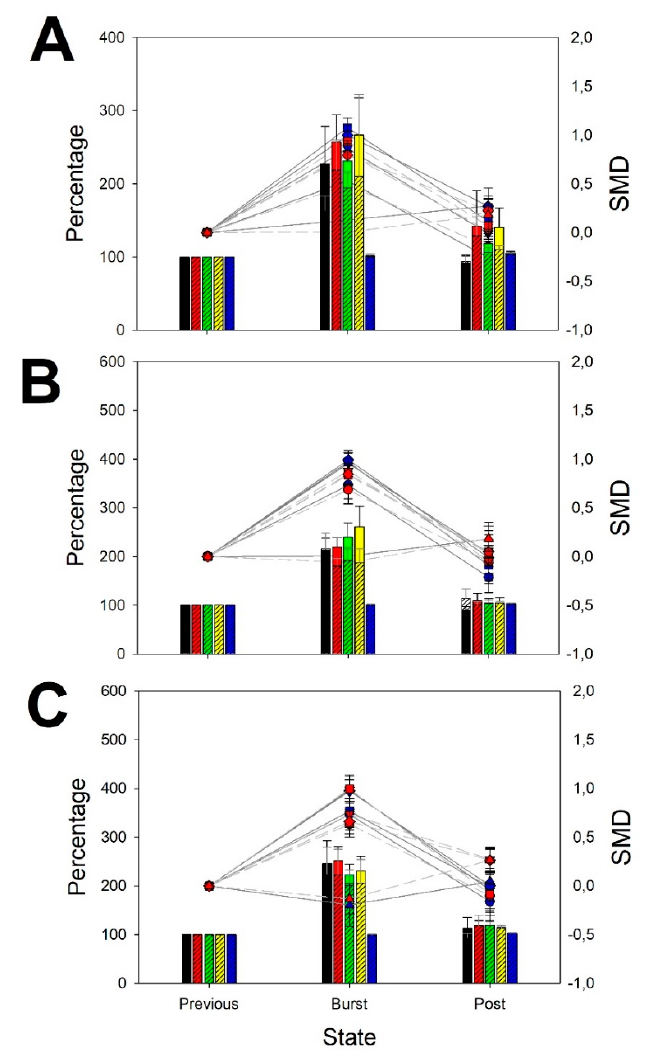
Figure 4. Normalized changes in power spectra and SMD during FS. ( A ) Frontal lobes; ( B ) parieto-occipital lobes and ( C ) temporal lobes. Bar graph (left y -axis): for every band and entropy, data from left (not-shaded color) and right hemisphere (shaded color) are superimposed ( δ = black, θ = red, α = green, β = yellow, Se = blue). Dot graph (right y -axis): SMD for every left (blue) and right hemisphere (red) for every band and entropy ( δ = circle, θ = down triangle, α = square, β = diamond, Se = up triangle).